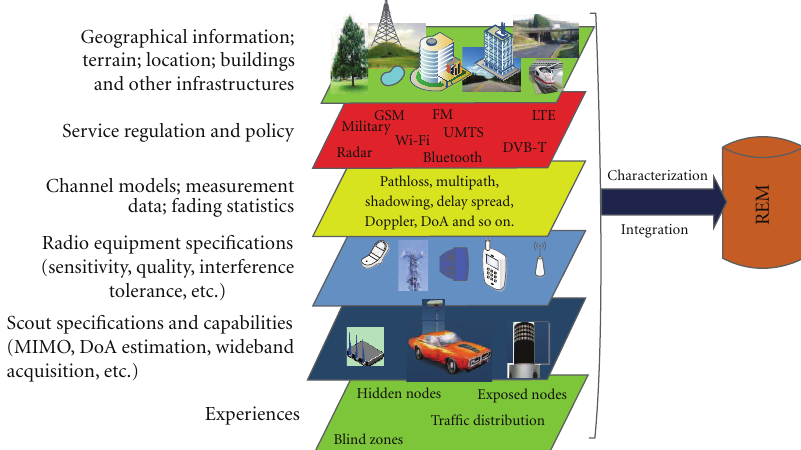
Figure 1: A REM obtained by integrating various databases (modified from